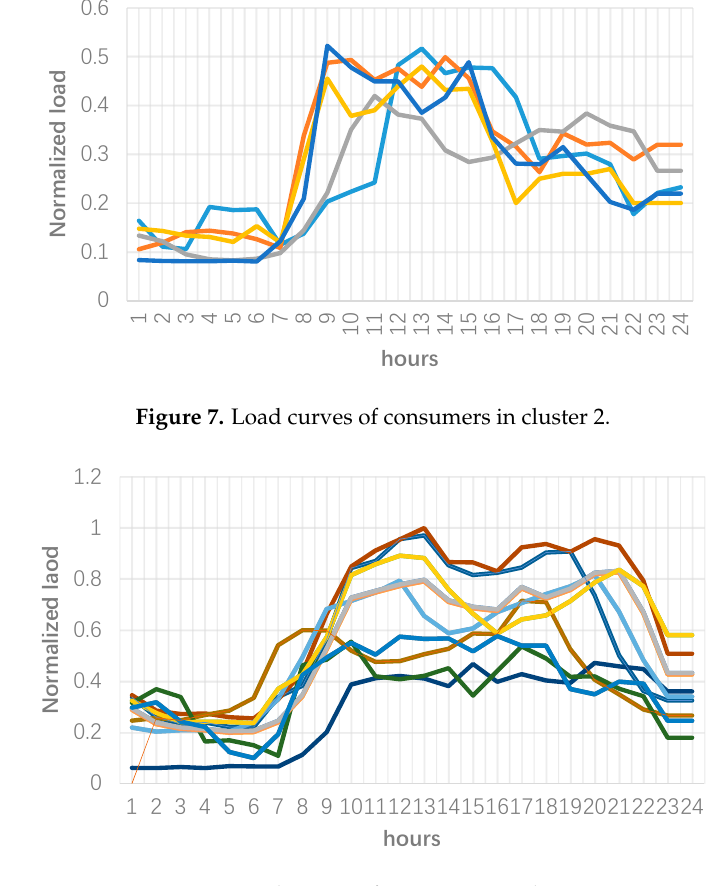
Figure 8. Load curves of consumers in cluster 3.